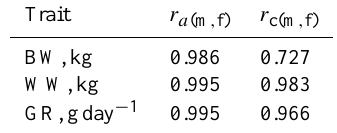
r a (m , f) : genetic correlation between males and females; r c(m , f) : maternal permanent environmental correlation between males and females; BW: birth weight; WW: weaning weight; GR: growth